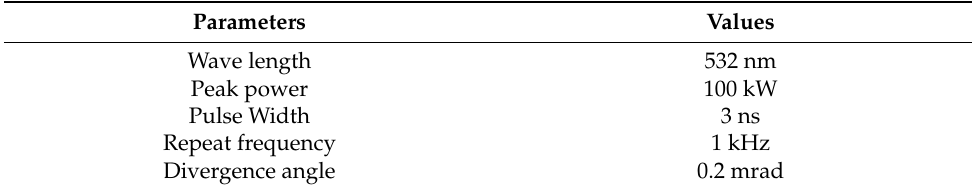
Figure 2. Laser purchased from market. Table 3. Specifications of laser selected from